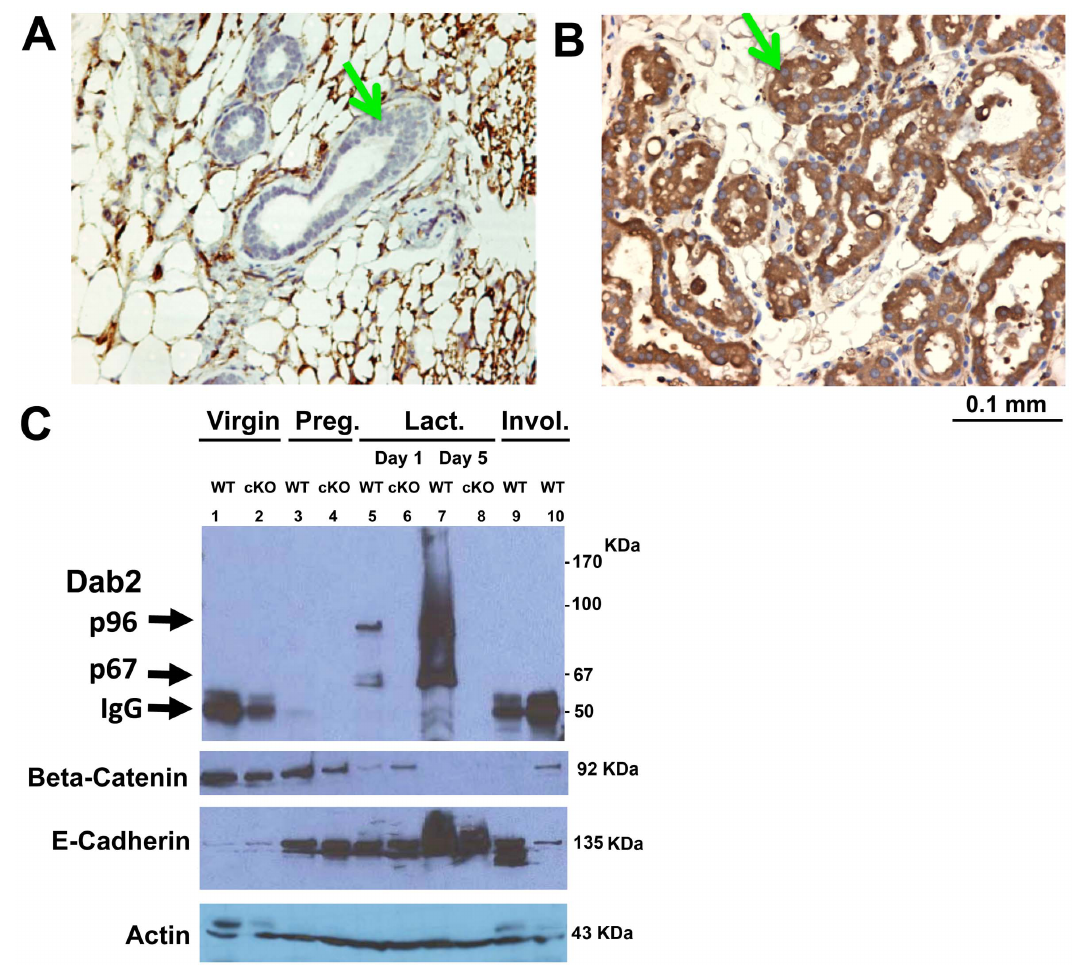
Figure 1. Induction of Dab2 by pregnancy and lactation in mammary glands. Mammary glands from virgin ( A ) and lactating ( B ) wildtype mice were harvested and used for histological analysis. Representative images of Dab2 immunostaining are shown. Arrows indicate the mammary epithelial cells. We also noted the positive staining of mammary adipocytes, which we have been confirmed to express Dab2 protein. ( C ) The induction of Dab2 proteins was confirmed by Western blot. Mammary glands were dissected and harvested from virgin, pregnant (Preg.) (12 days), and day 1 and day 5 of lactating (Lact.), and post-lactating/involuting (Invol.) wildtype (WT) mice. The post-lactation/involution samples were harvested from mothers that were weaned naturally. Specifically, the mice lactated for 3 weeks prior to separation from their pups for 1 (lane 9) or 3 (lane 10) days. Mammary tissues from conditional Dab2 knockout mice ( dab2 (f/df):Meox2-Cre) (cKO) were used as controls for antibody specificity. The tissues were lysed in SDS buffer, and equal protein from each sample was used for electrophoresis and Western blot analysis of Dab2, beta- catenin, and E-cadherin. Arrows indicate Dab2 p96 and p67 isoforms and a band that is presumably IgG heavy chain.